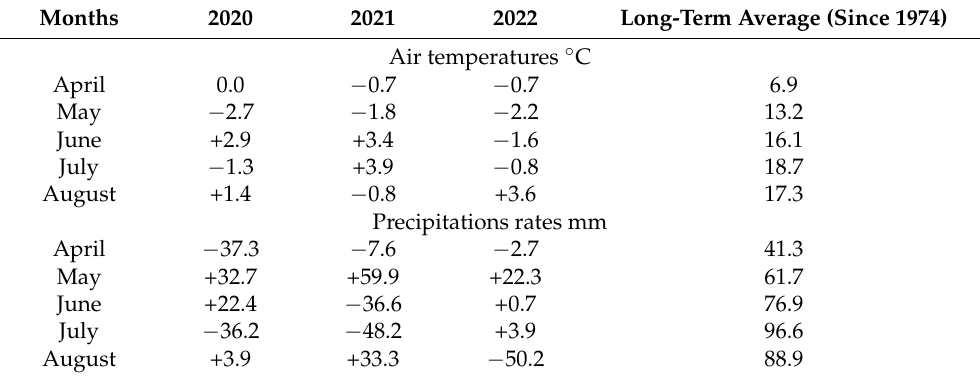
Table 1. Differences ( ± ) of air temperatures and precipitation rates from the long-term average during the 2020–2022 vegetative seasons. Kaunas Meteorological Station.